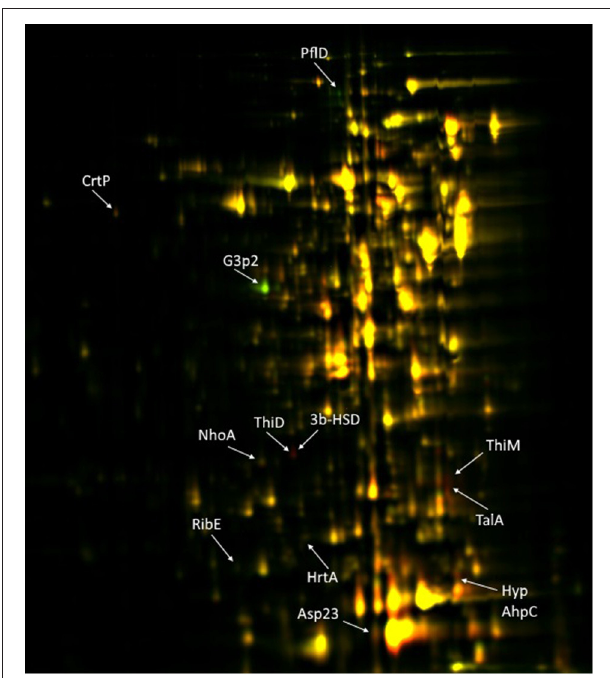
FIGURE 6 | 2D-DIGE of cellular proteins isolated from CH21 and ch22 strains. Protein spots positively differentiating in VIR CH21 and NVIR ch22 are more intensive in red and green canal, respectively. Protein spots with equal expression in both strains are yellow. Identified differentiating proteins are marked with